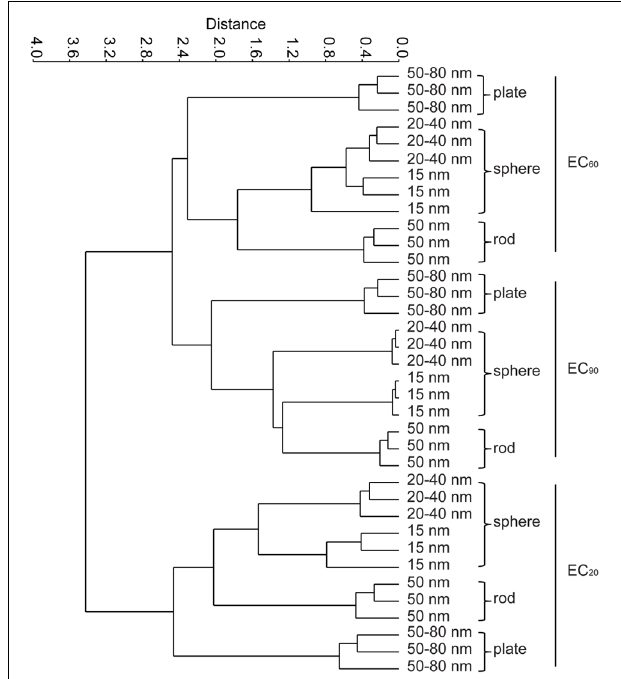
FIGURE 4 | Classifications of four different AgNPs treatments by cluster analysis according to the metabolic characteristics of the microbial communities at the EC 20 , EC 60 , and EC 90 levels. Two-way ANOSIM, Euclidean-based similarity, n = 3, EC level R = 0.953, p = 0.0001; shape R = 0.876, p = 0.0001,